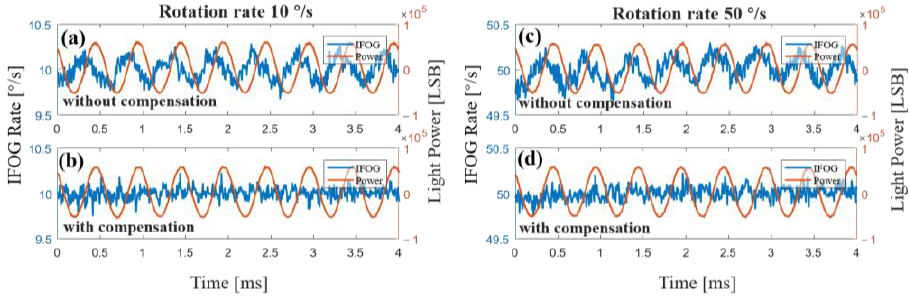
Figure 12. Experimental results of the gyroscope without ( a , c ) and with ( b , d ) compensation when the gyroscope was in motion. The driving current of the SLD in the experiments was the same: a sine wave with a bias of 100 mA, an amplitude of 1 mA, and a frequency of 2 kHz. ( a , b ) Rotation rate was 10°/s. ( c , d ) Rotation rate was 50°/s.